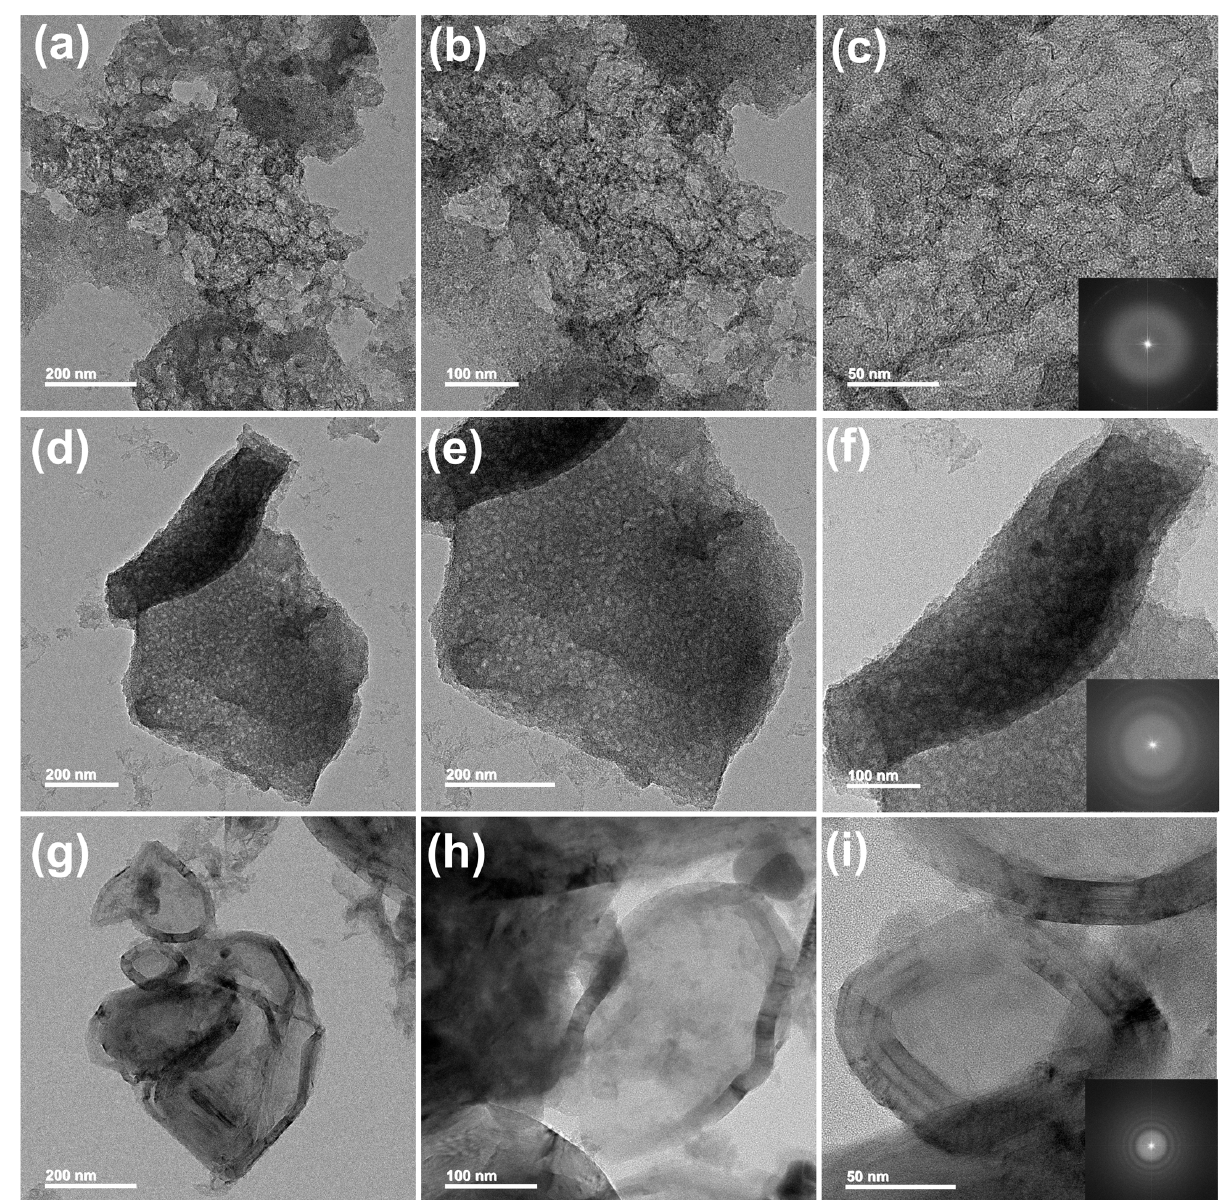
Figure 2. FE-TEM images of the ( a – c ) NBP-PC-Mg, ( d – f ) NBP-PC-Fe, and ( g – i ) NBP-PC-Zn samples (Inset: c, f and i are show the related FFT patterns).